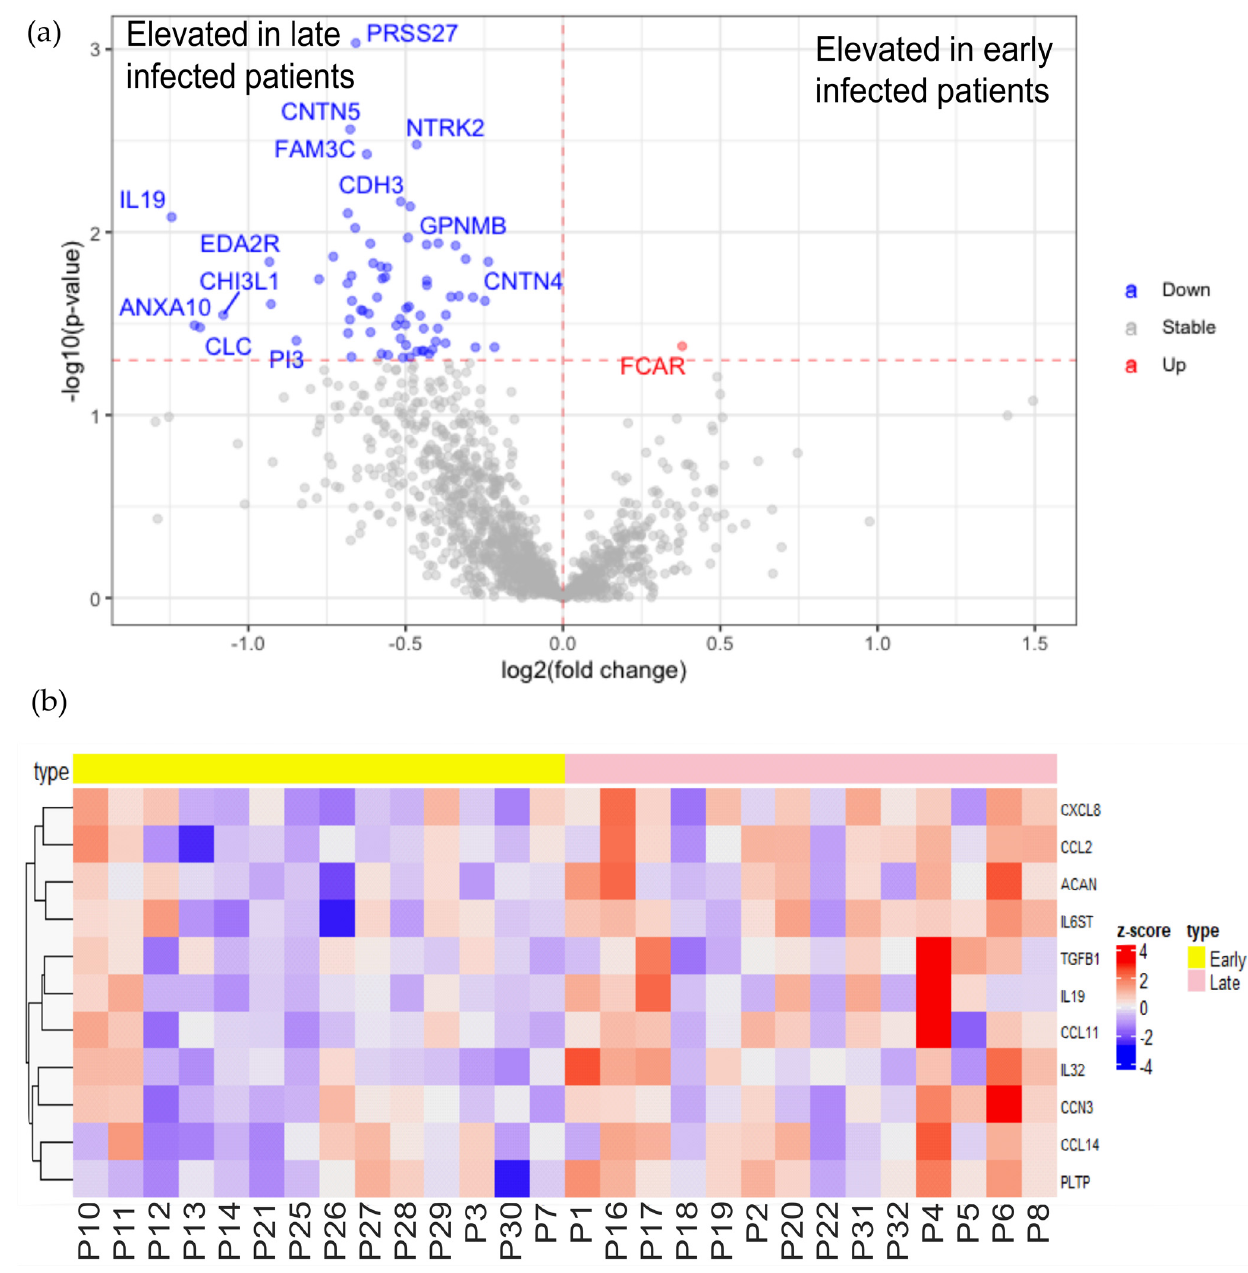
Figure 3. Characterization of long-term plasma protein responses associated with SARS-CoV-2 infection. ( a ) Volcano plot of statistical significance against fold-change of proteins between patients with plasma samples collected less than 3 months after infection (early) and collected more than 3 months after infection (late). Red (upregulated in patients with early collection) and blue (upregulated in patients with late collected plasma) dots indicate statistically DEPs; ( b ) heatmap of selected statistical DEPs between patients with plasma collected less than 3 months after infection (early) and collected more than 3 months after infection (late) with z-score by row normalization and distributed by hierarchical clustering.